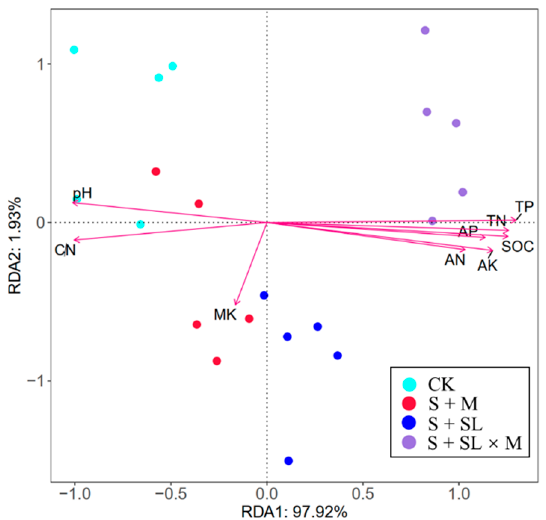
Table 4. Correlation analysis of chemical properties and biological characteristics of the soil.